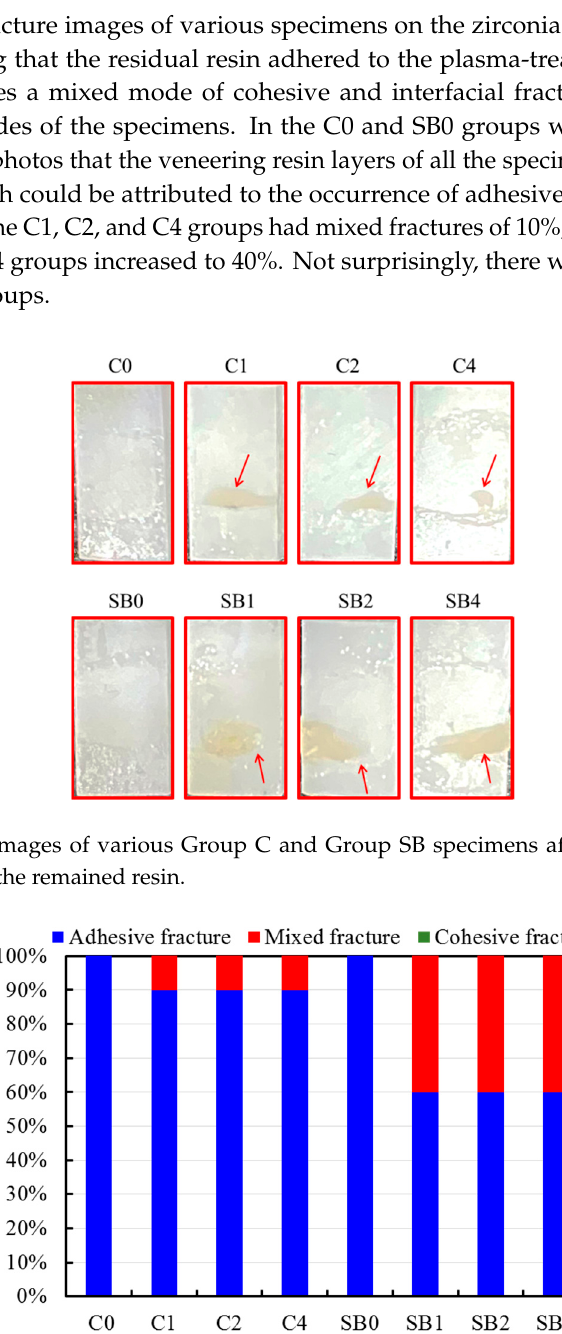
Figure 7. Shear strength of the bonding of the plasma-treated Y-TZP samples to resin. The different letters indicate significant differences (p < 0.05) (n = 10).